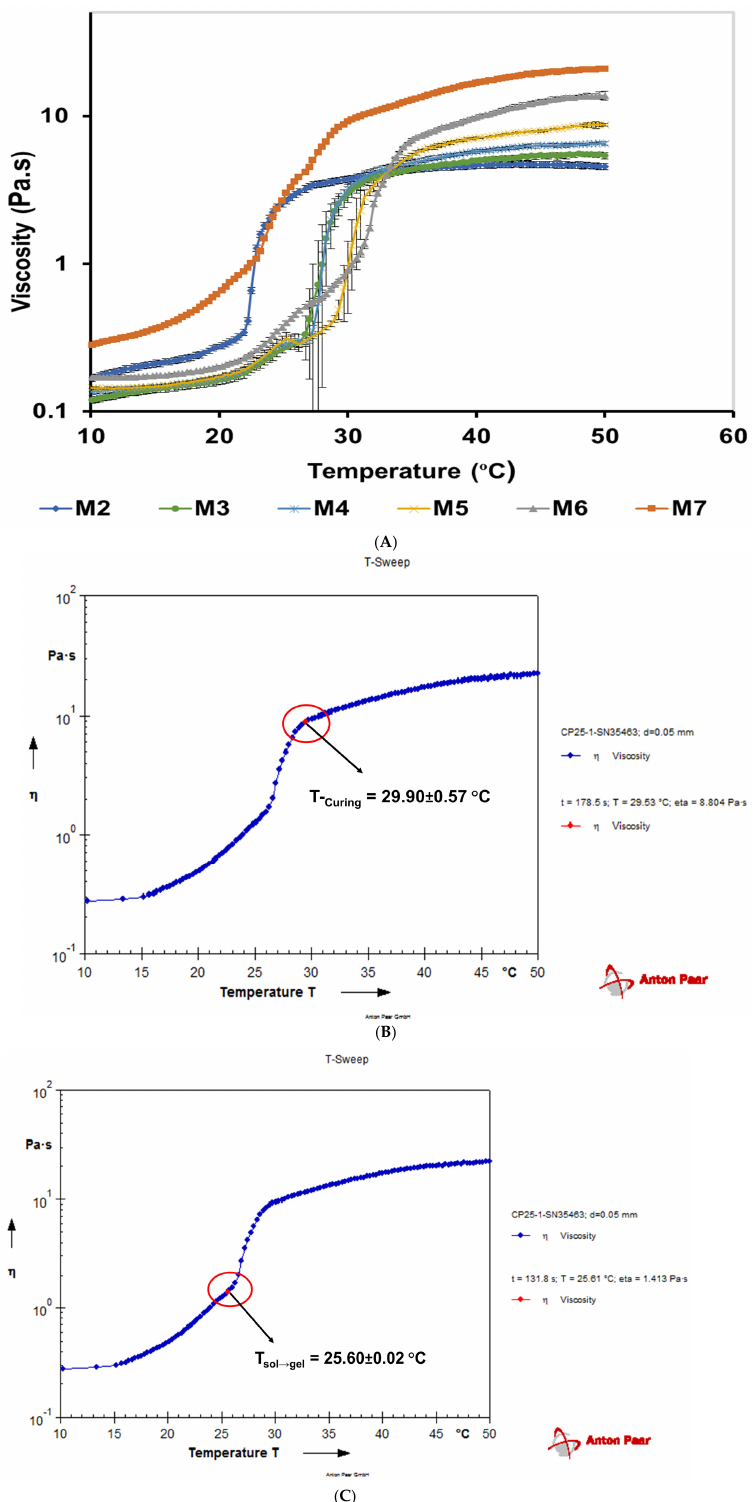
Figure 7. ( A ) The temperature–sweep tests illustrating the phase transition profiles of M 2 − 7 microgels determined using controlled-stress rheometer (CRS), ( B ) determination of the sol transition temperature (T sol → gel ) of M7 microgel from its phase transition profile as indicated by an arrow, and ( C ) determination of the curing temperature (T- Curing ) of M7 microgel from its phase transition profile as indicated by an arrow.